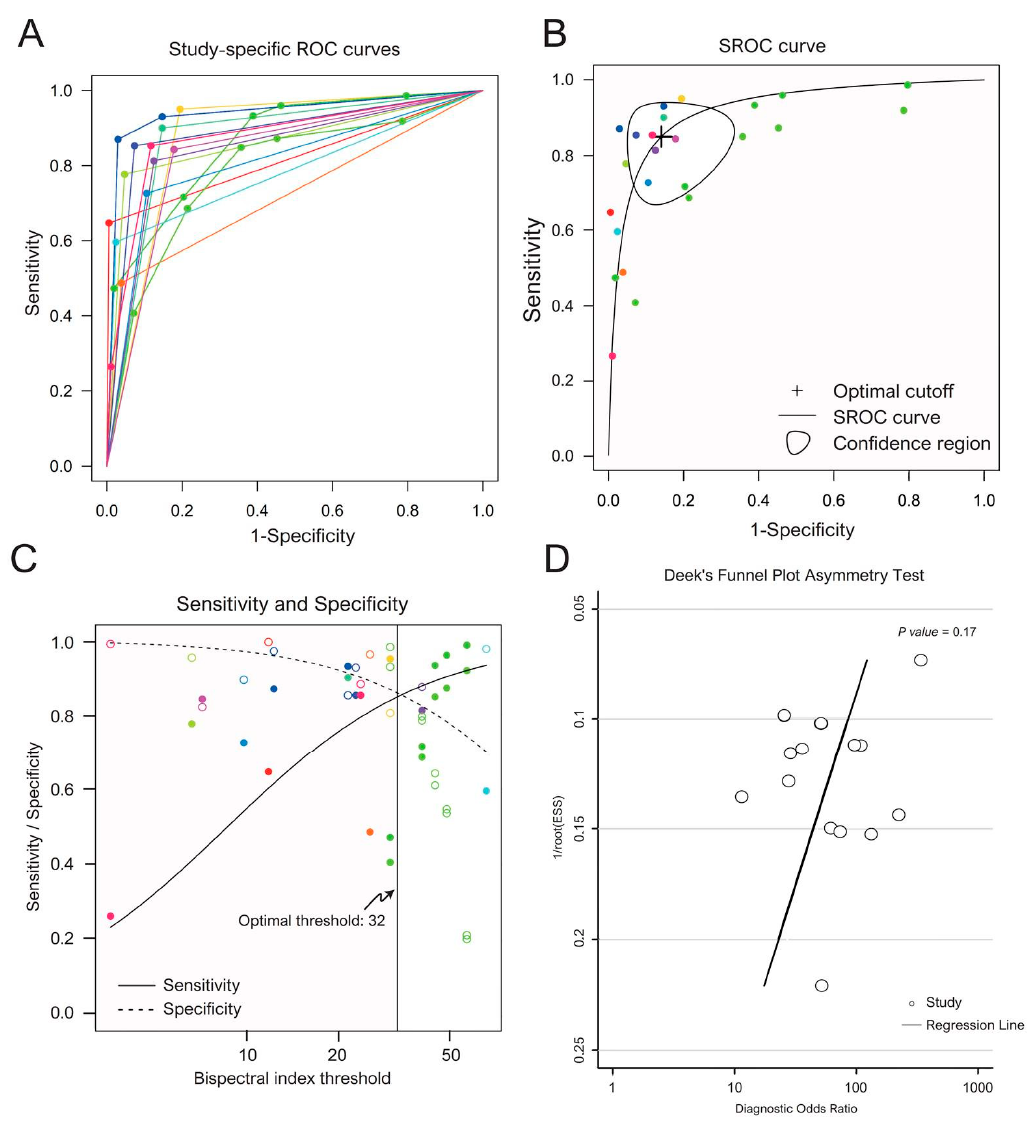
Figure 4. ( A ) Study-specific receiver operating characteristic (ROC) curves. ( B ) Summary receiver operating characteristic (SROC) curve. The points represent the pair of sensitivity and specificity at a given threshold in each included study. Points of same color belong to the same primary study. The cross mark represents the pooled sensitivity and specificity at the optimal cutoff (BIS = 32 ) . ( C ) Trade-off of sensitivity and specificity. The pairs of open circle and filled circle represent the sensitivity and specificity at a given threshold. Circles of same color belong to the same study at different given thresholds. The vertical solid line represents the optimal threshold. ( D ) Deek’s funnel plot. The regression test showed no significant publication bias ( p = 0.17).